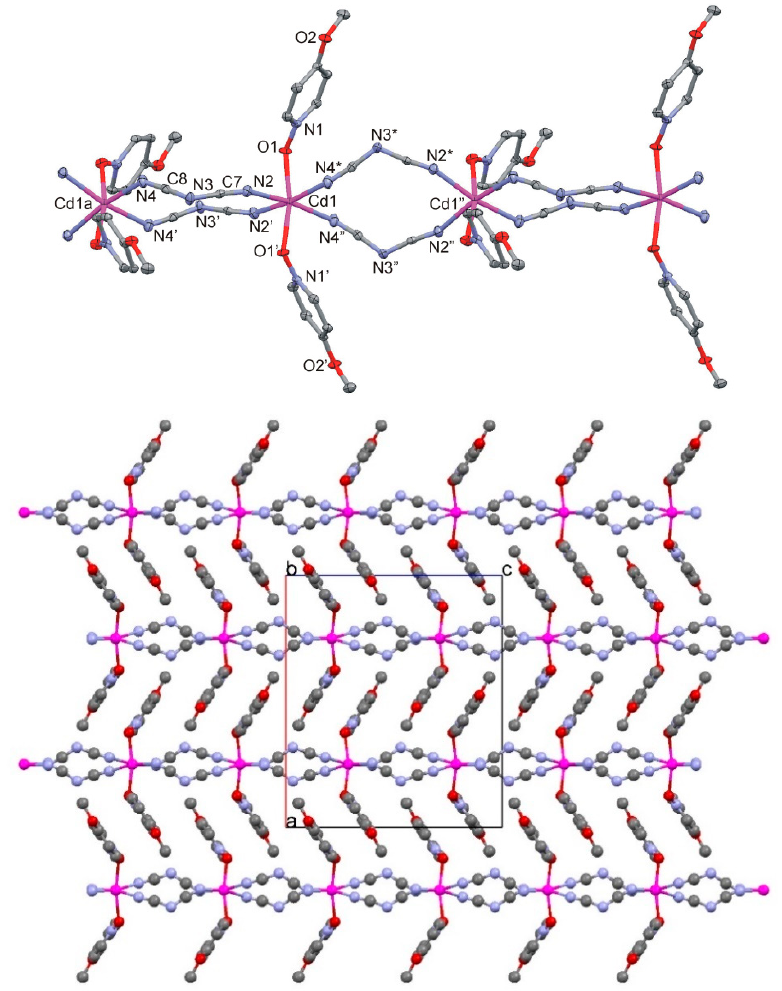
Figure 3. ( top ) One dimensional (1D) chain system of 3 . Symmetry operations: (’) 3/2-x,3/2-y,z; (”) x,3/2-y,1/2-z; (*) 3/2-x,y,3/2+z, (a) x,3/2-y,-1/2-z; ( bottom ) packing plot of 3 .